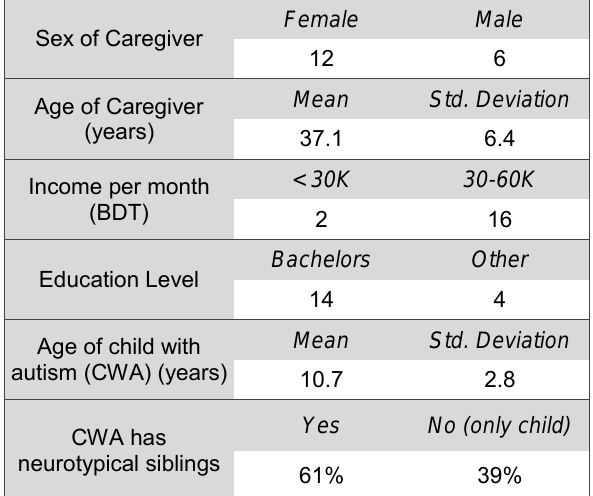
Table 1. Caregiver